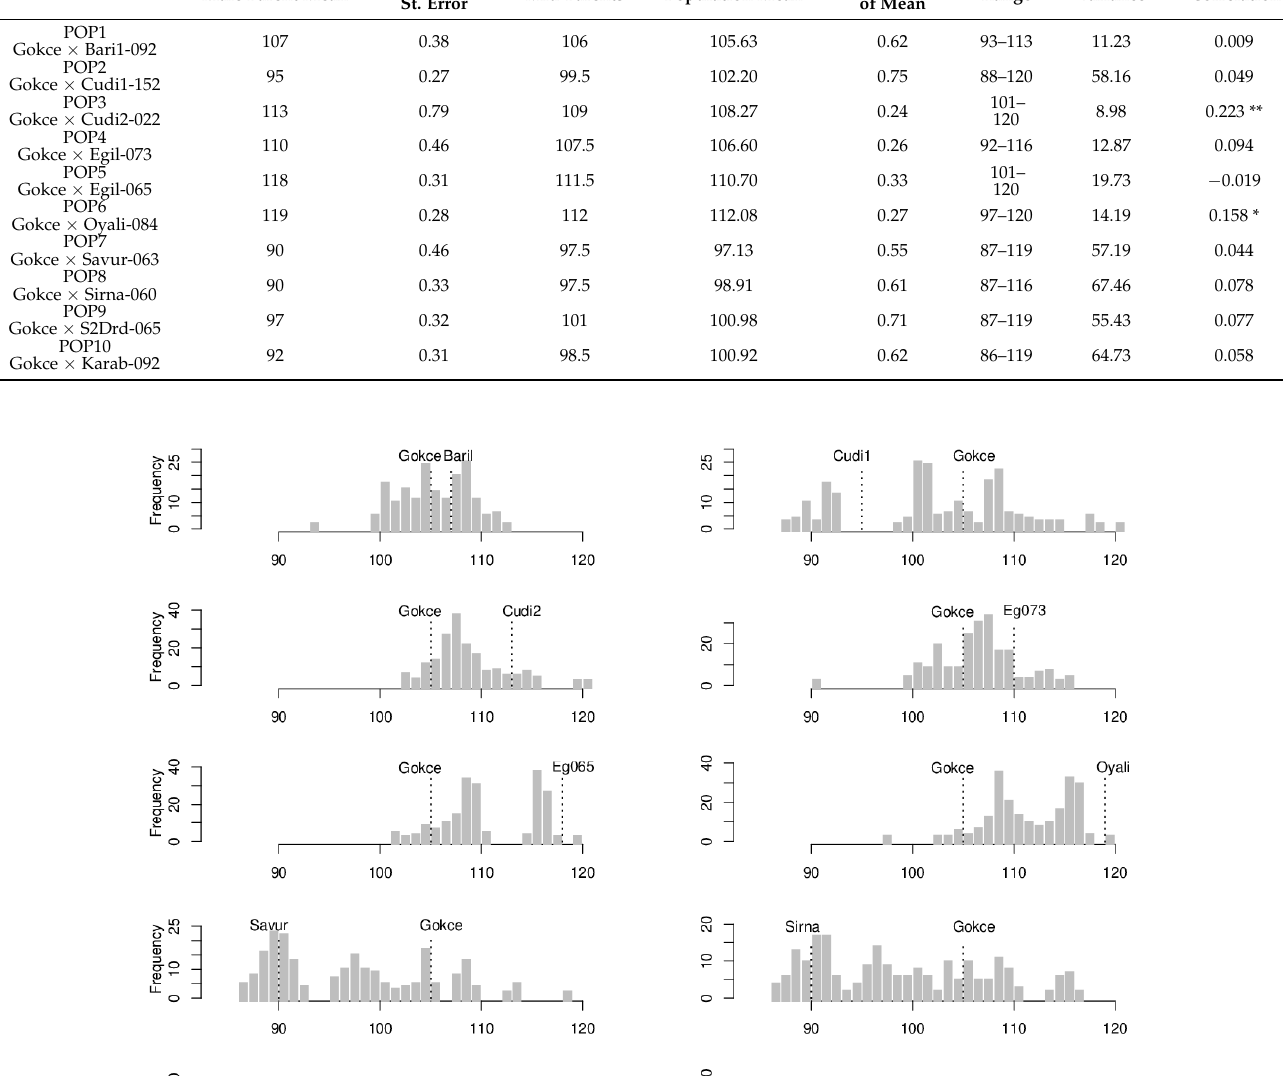
Table 2. Summary of flowering time observations for chickpea NAM populations. The female par- ent was Gokce (mean = 105, se = 0.09) and the male parent was the wild genotype in all populations. Correlations with flower color are shown. Correlations were insignificant unless followed by aster- isks (* means p < 0.05, ** means p < 0.01).